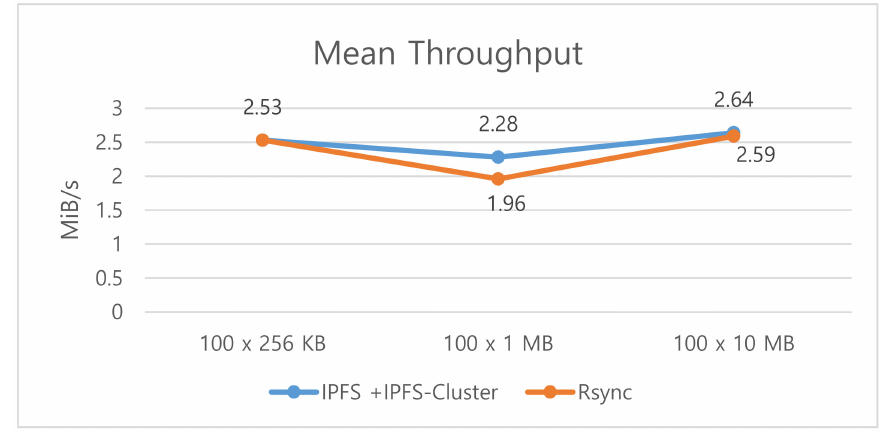
Figure 12. Mean throughput of a node.